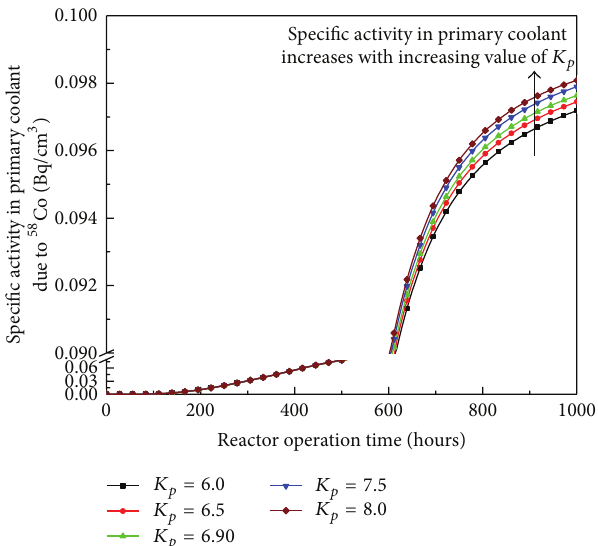
Figure 10: Specific activity of 58 Co in primary coolant of PWR with different values of 𝐾 𝑝 .